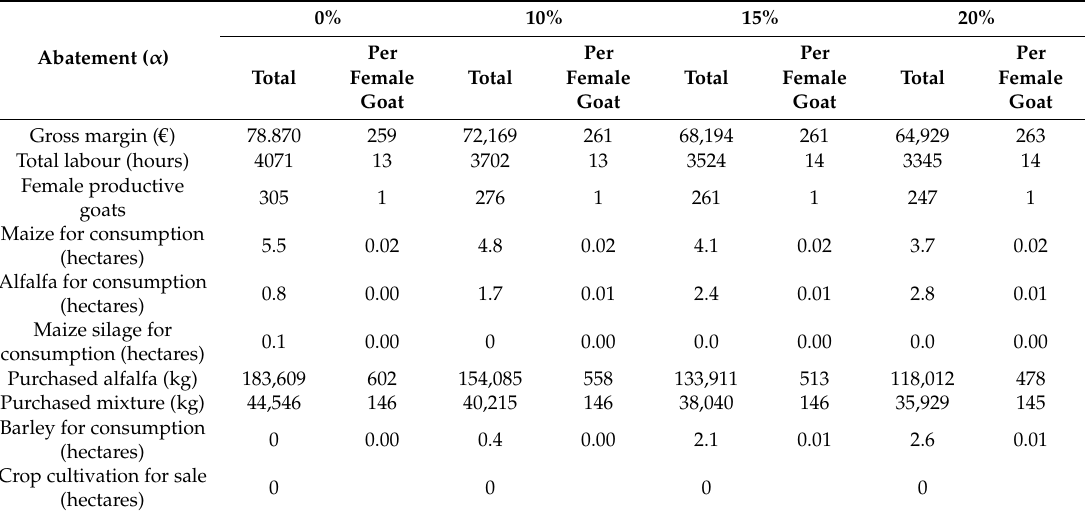
Table 11. Optimal farm plan of the intensive